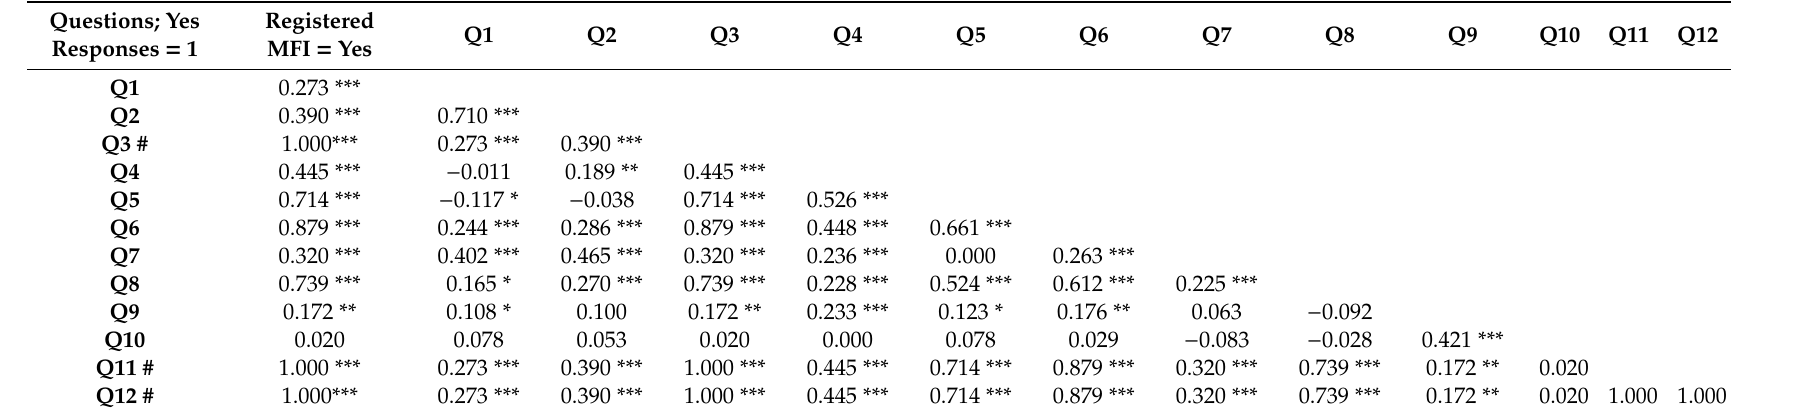
Table 2. Pearson’s